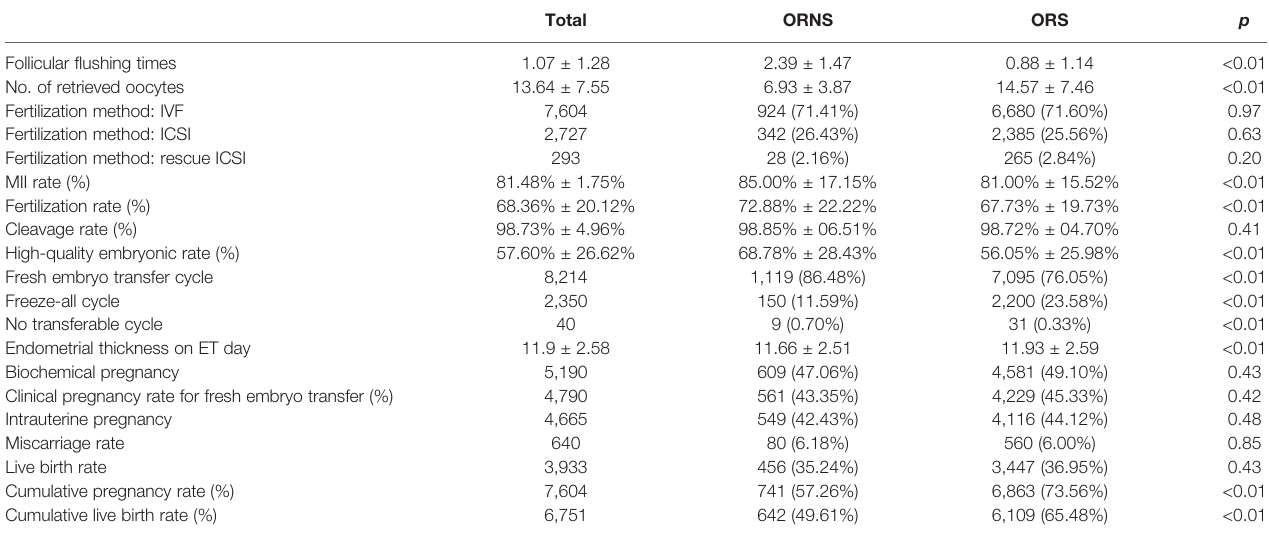
TABLE 4 | Comparisons between the ORNS and ORS after oocyte retrieval to embryo transfer.